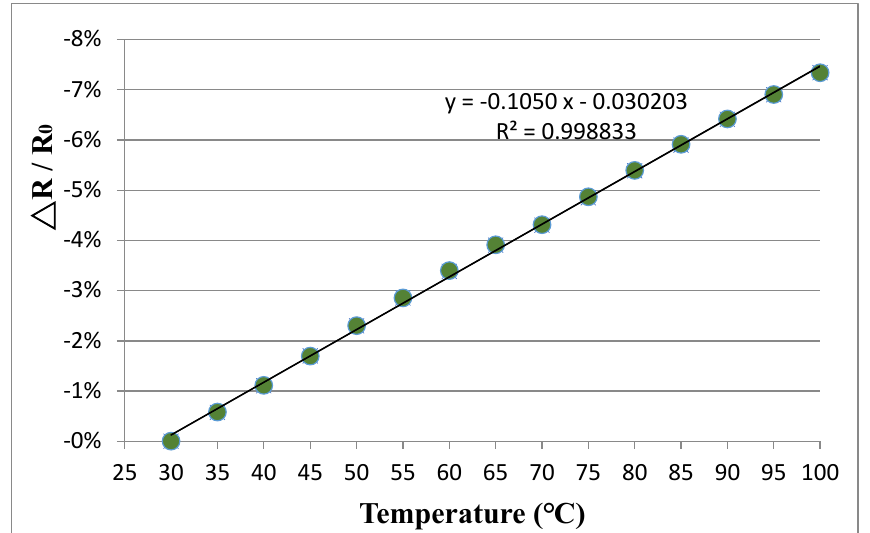
Figure 15. Relative resistance change vs. temperature change for the buckypaper made of low aspect ratio MWCNTs.